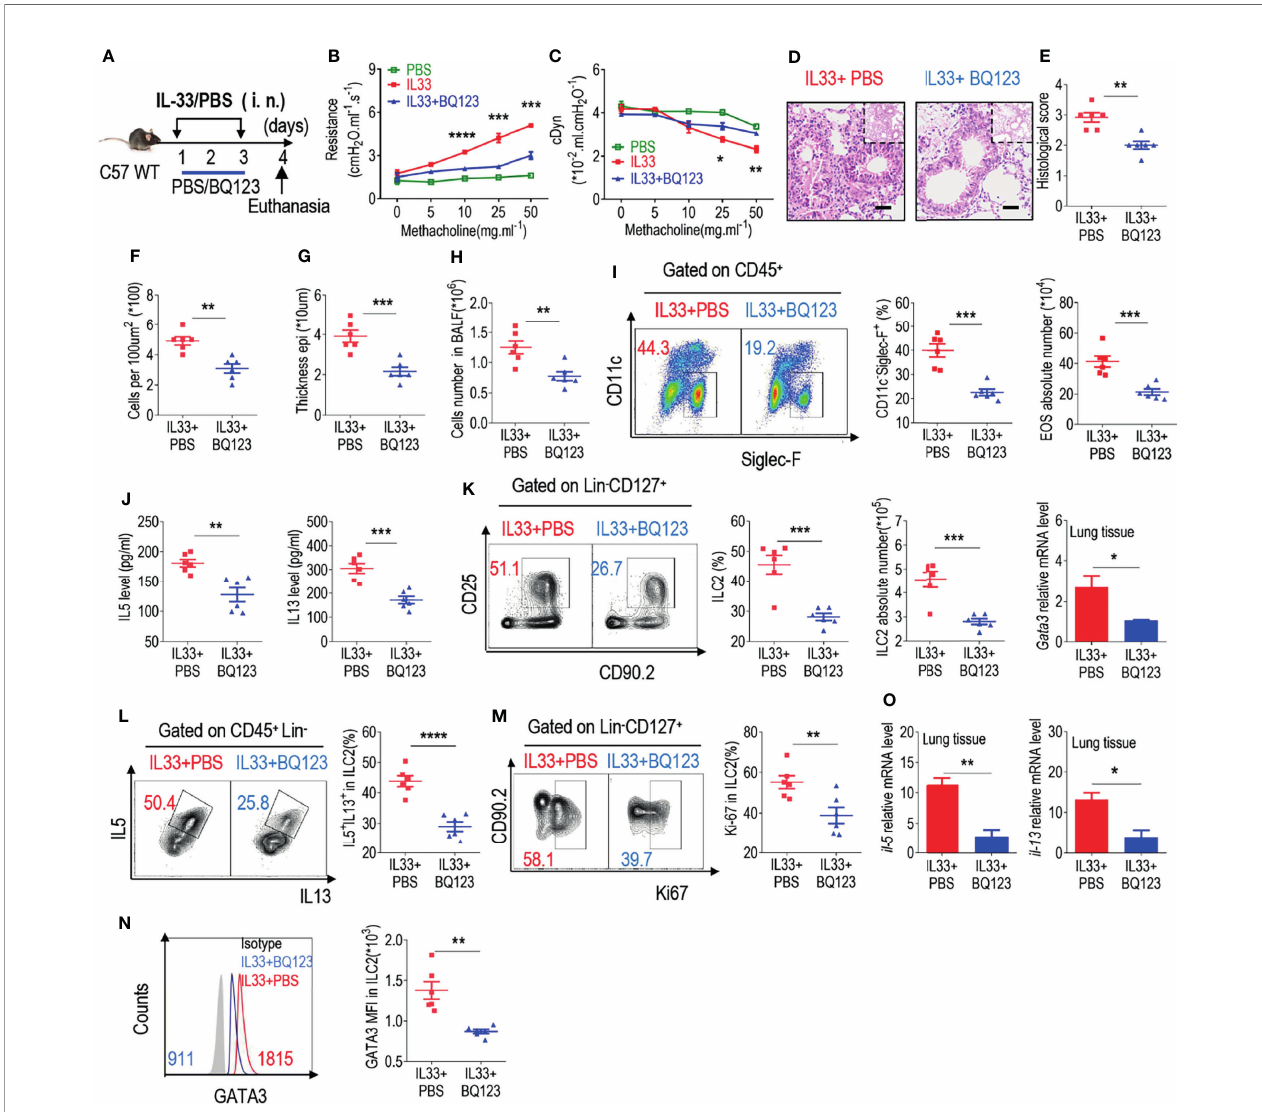
FIGURE 2 | BQ123 inhibited the functional activation of ILC2s in response to IL-33 challenge. (A) Experimental scheme. Female C57BL/6J mice were intranasally challenged with IL-33 on days 1 – 3 and were sacri fi ced 24 h after the last challenge on day 4. (B, C) Line graphs show lung resistance and dynamic compliance (cDyn) in response to increasing doses of methacholine. (D – G) Representative hematoxylin and eosin (H&E) staining of lung sections (D) and in fl ammation scores (E) , as well as the in fi ltrating cells (F) and airway epithelium thickness (G) were presented. Absolute number of BALF (H) , both fl ow cytometry and statistical results of population, and the absolute number of EOS in the BALF (I) were shown. (J) Amounts of IL-5 and IL-13 in the BALF. (K – N) Representative results of both fl ow cytometry and statistical analysis of the frequencies of ILC2s, and absolute counts (K) , IL-5 + IL-13 + ILC2s (L) , Ki67 + ILC2s (M) , and levels of GATA3 protein (N) in the lungs were indicated. (O) The mRNA expression levels of ILC2-related target genes in lung tissues, including Il5, Il13 , and Gata3 , were evaluated; b -actin level was used for normalization, and the lowest expression level in the IL33 + BQ123 group was arti fi cially set to 1 (n = 3). Data are representative of two or three independent experiments (n = 6 for the IL33 + phosphate-buffered saline (PBS) group; n = 6 for the IL33 + BQ123 group). *P < 0.05; **P < 0.01; ***P < 0.001; ****P < 0.0001. In all panels, individual results and mean ± standard error of the mean (SEM) are shown; statistical signi fi cance was determined using a two-tailed unpaired Student ’ s t-test (B, C, E – M, O) or Mann-Whitney test (N)